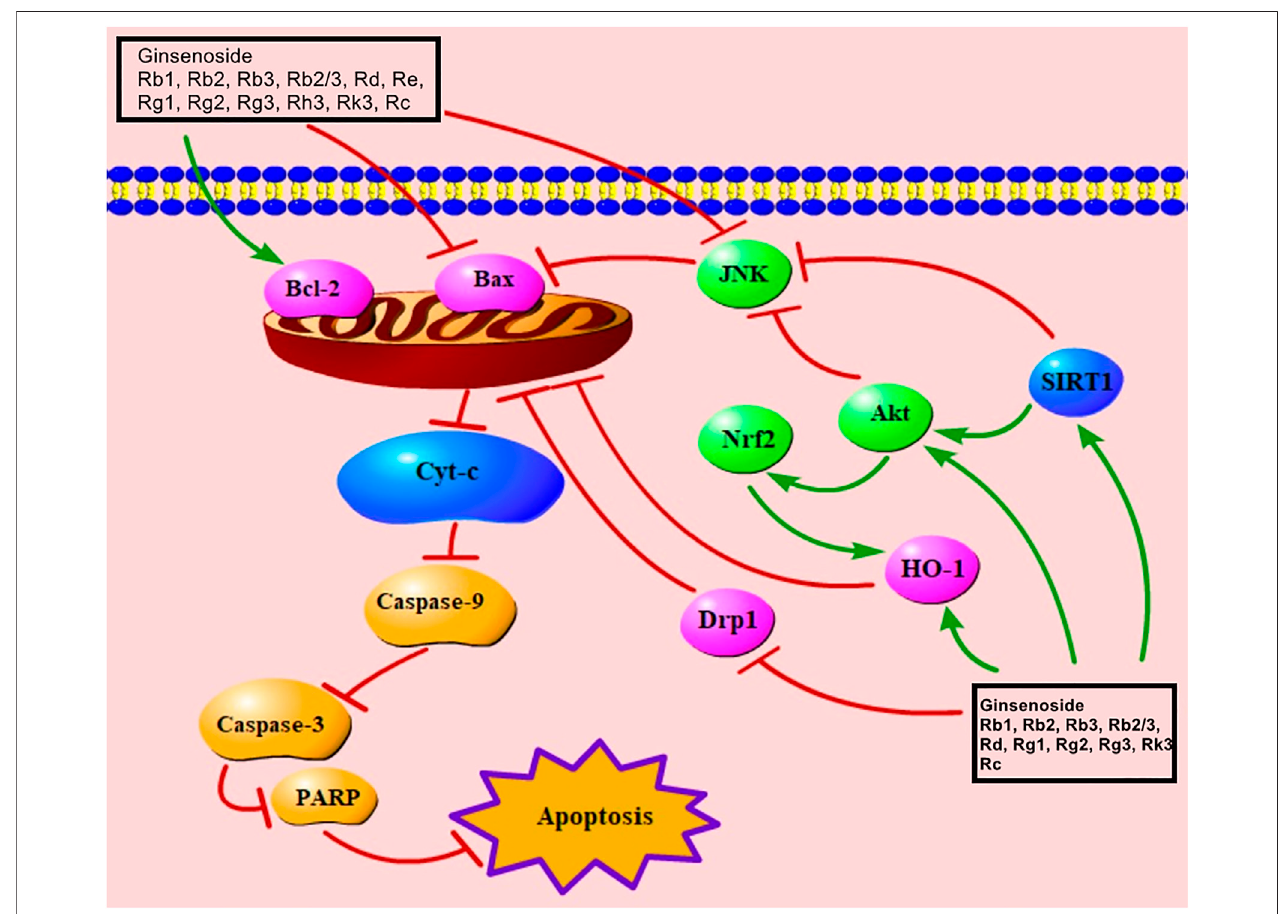
FIGURE4| Mitochondria-mediated signaling pathwayofginsenosideinrelievingMCapoptosis. Cyt-C,cytochromeC;PARP,poly(ADP-ribose) polymerase; Nrf2, nuclear factor E2 – related factor 2; SIRT1, sirtuin 1; Drp1, dynamin-related protein 1; HO-1, heme oxygenase-1.